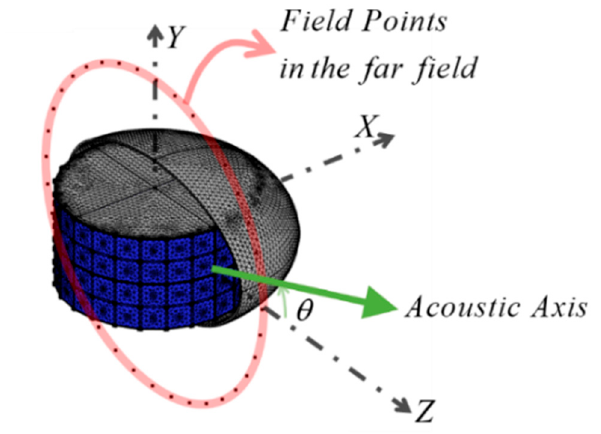
Figure 12. Location of field points for calculating beam pattern.